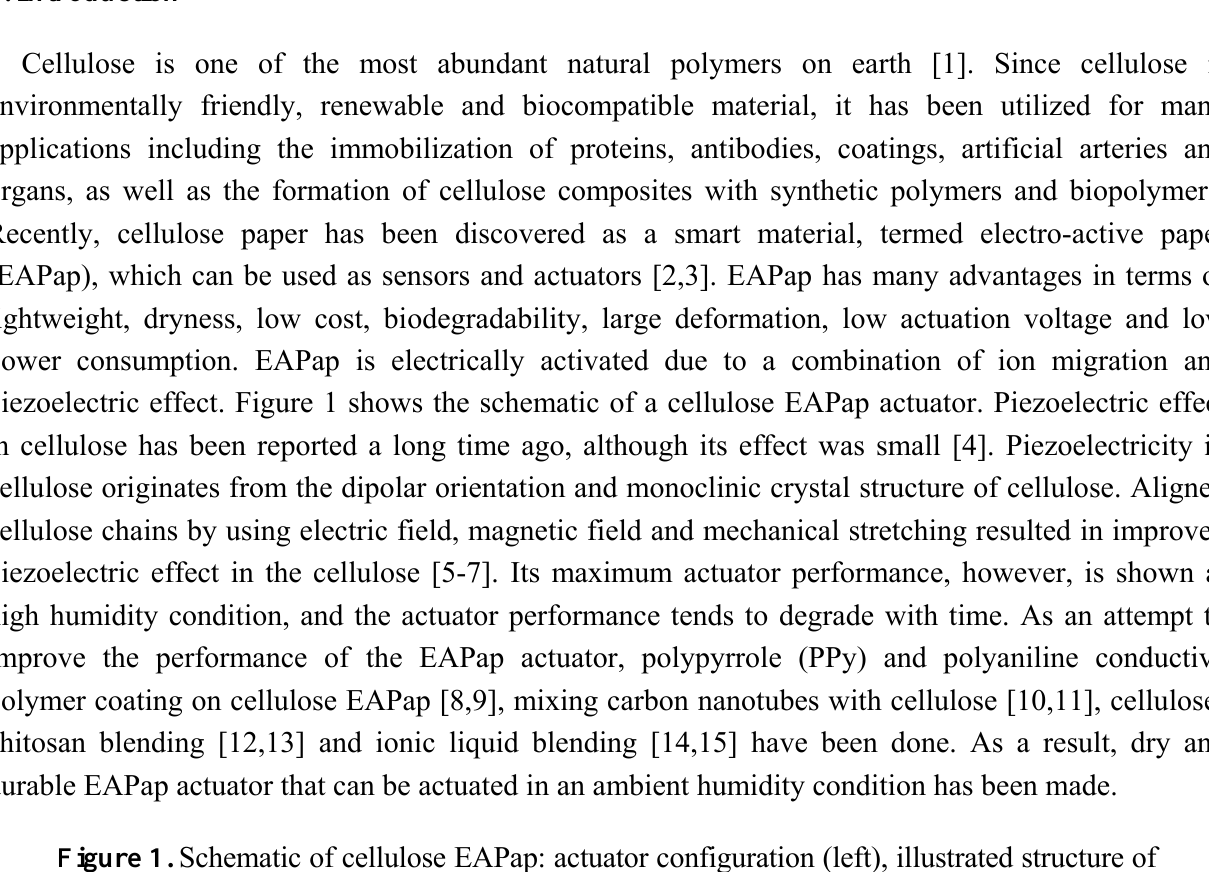
Figure 1. Schematic of cellulose EAPap: actuator configuration (left), illustrated structure of regenerated cellulose film (middle) and distribution of water molecules with Cl - ions